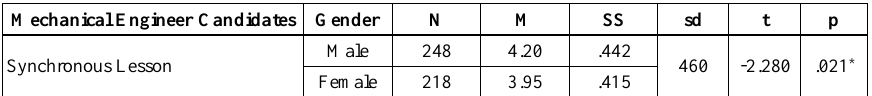
Table 5. Distribution of synchronous course status of mechanical engineer programme candidates according to